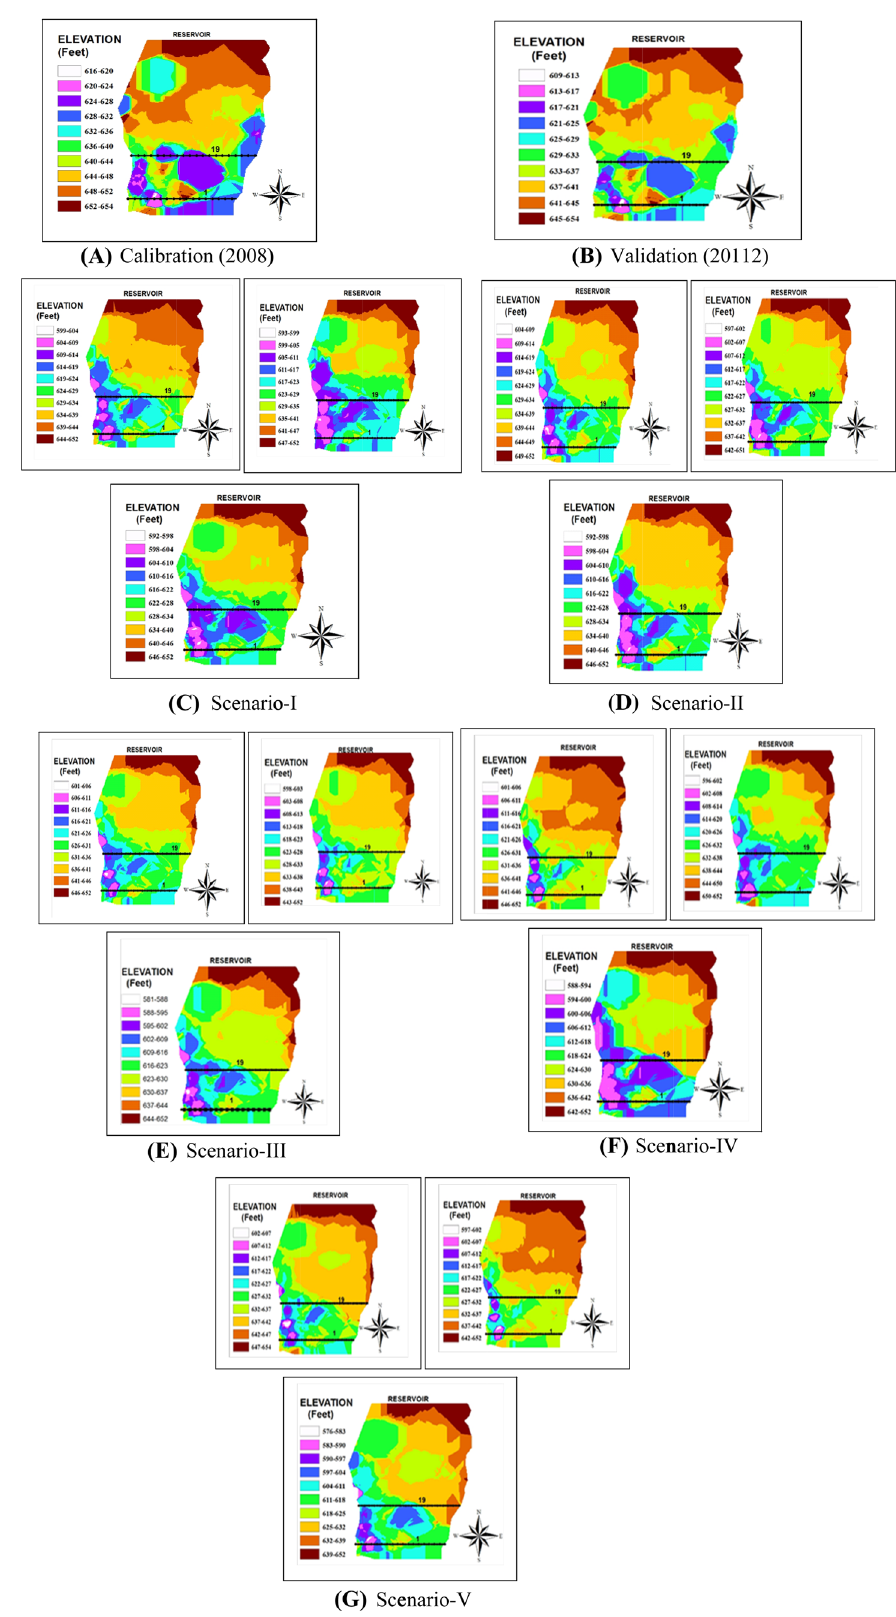
Fig. 11 Simulated bed profiles of Chashma Reservoir using various